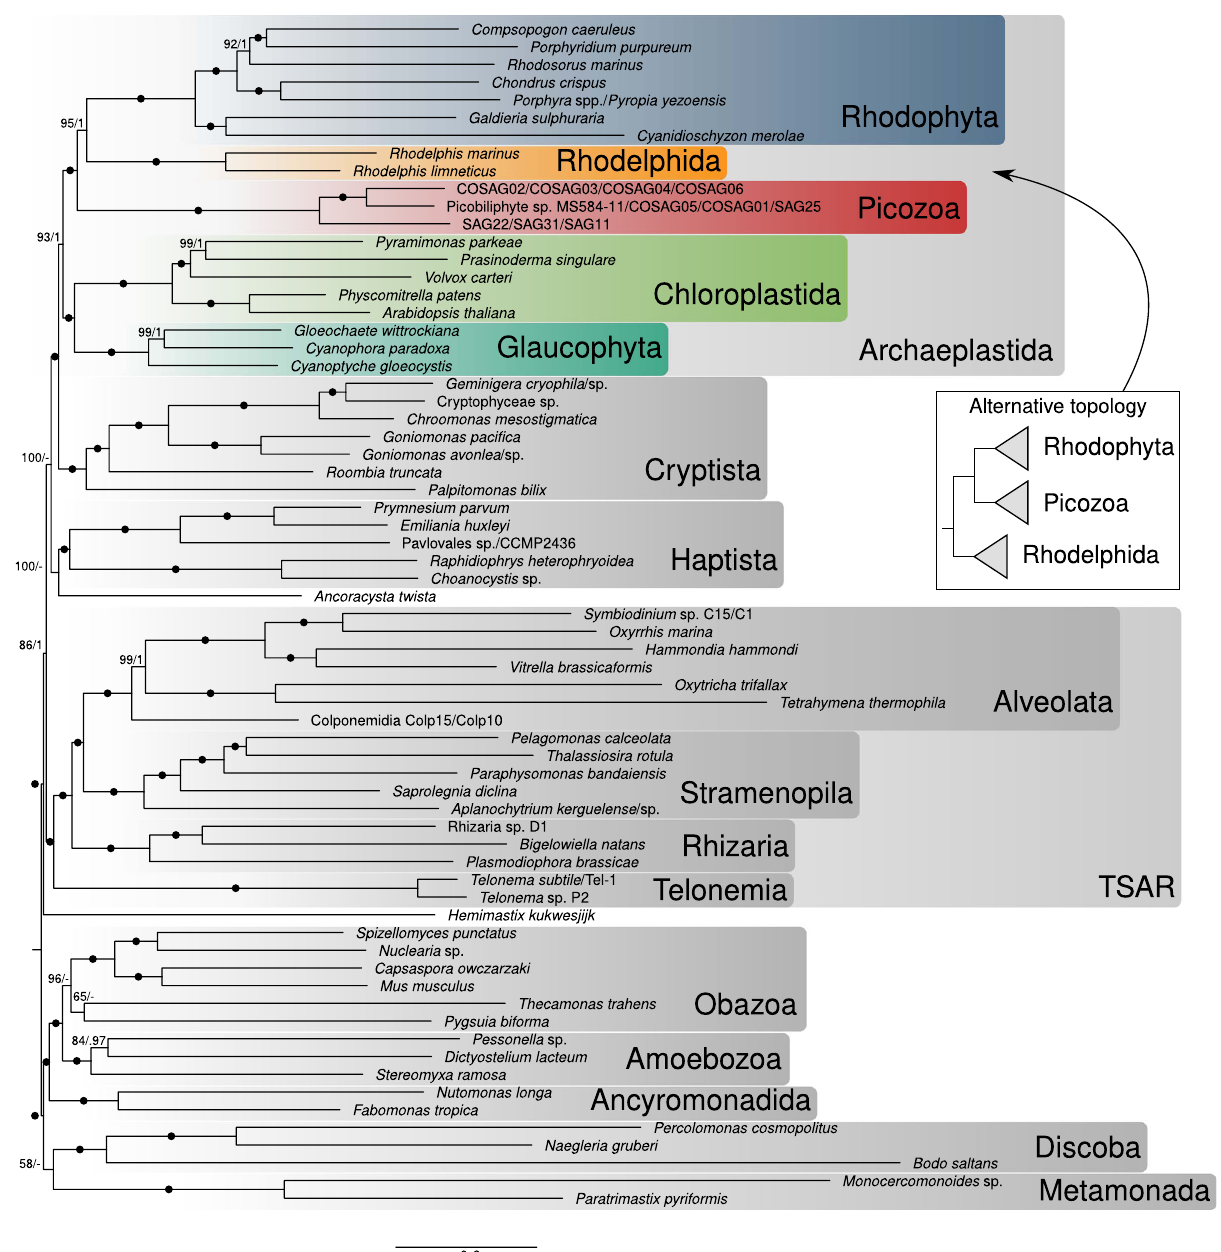
Fig. 2 Maximum likelihood tree of eukaryotic species showing the position of Picozoa. The tree is based on the concatenated alignment of 317 marker genes and was reconstructed using the site-heterogeneous model LG + C60 + F + G-PMSF. Support values correspond to 100 non-parametric bootstrap replicates/posterior probability values estimated using PhyloBayes CAT-GTR + G. Black circles denote full support ( = 100/1.0). Insert shows the only other topology not rejected in an AU topology test, which was also recovered when trimming the 50% most heterogeneous sites of the